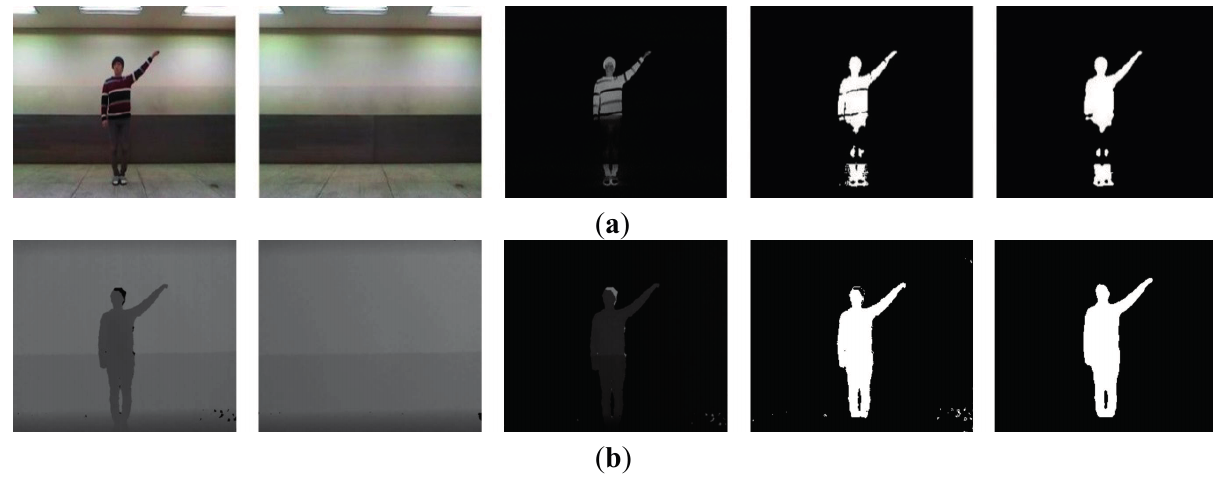
Figure 14. Difference of color and depth images in segmentation: ( a ) color-based segmentation; ( b ) depth-based